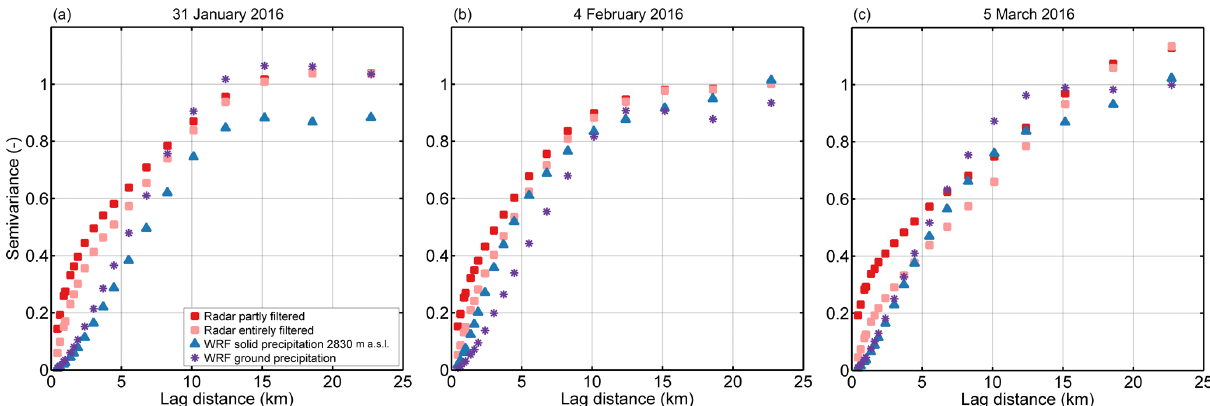
Figure 6. Variograms of detrended snow precipitation normalized by the domain-wide variance of precipitation for the precipitation events on (a) 31 January 2016, (b) 4 February 2016 and (c) 5 March 2016 for the regional domain (450m horizontal grid spacing, Fig. 1). Variograms are given for partly filtered (red) and entirely filtered (orange) radar snow precipitation, WRF snow precipitation at 2830m above sea level (ma.s.l., blue) and WRF total ground precipitation (violet). WRF precipitation is from simulations with weak terrain smoothing (Sect. 2.1). All precipitation fields are